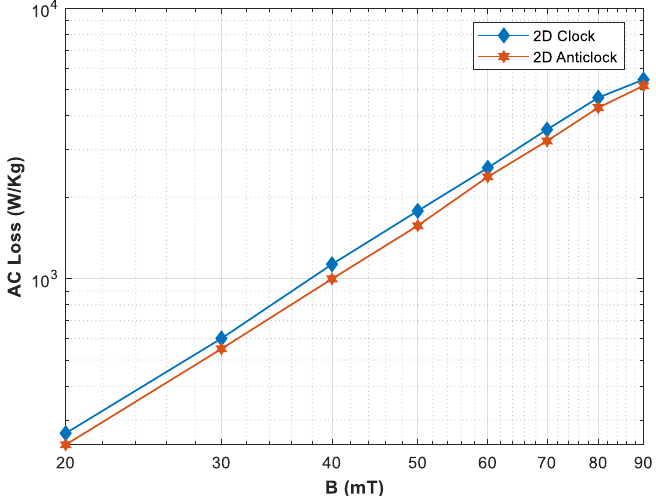
Figure 7. Comparison of measured AC loss subjected to rotating magnetic fields with clockwise and anticlockwise orientation.